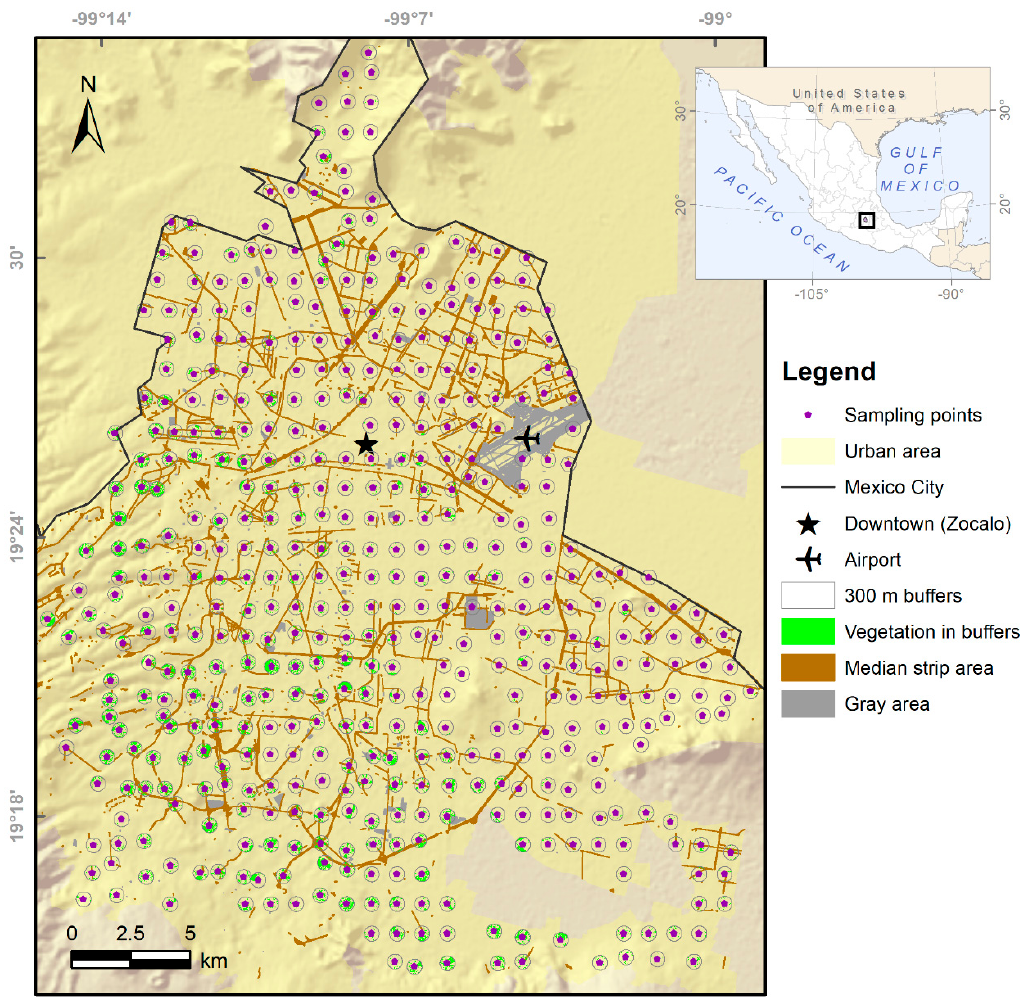
Figure 1. The study site and sampling point locations.